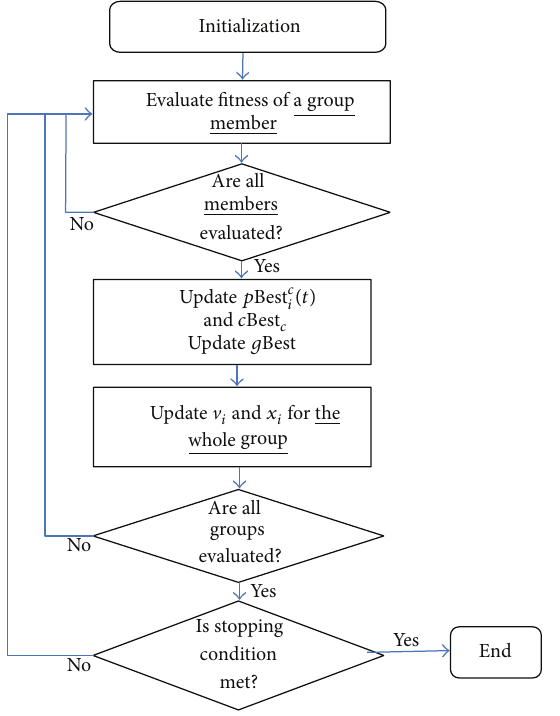
Figure 3: SA-PSO flowchart.